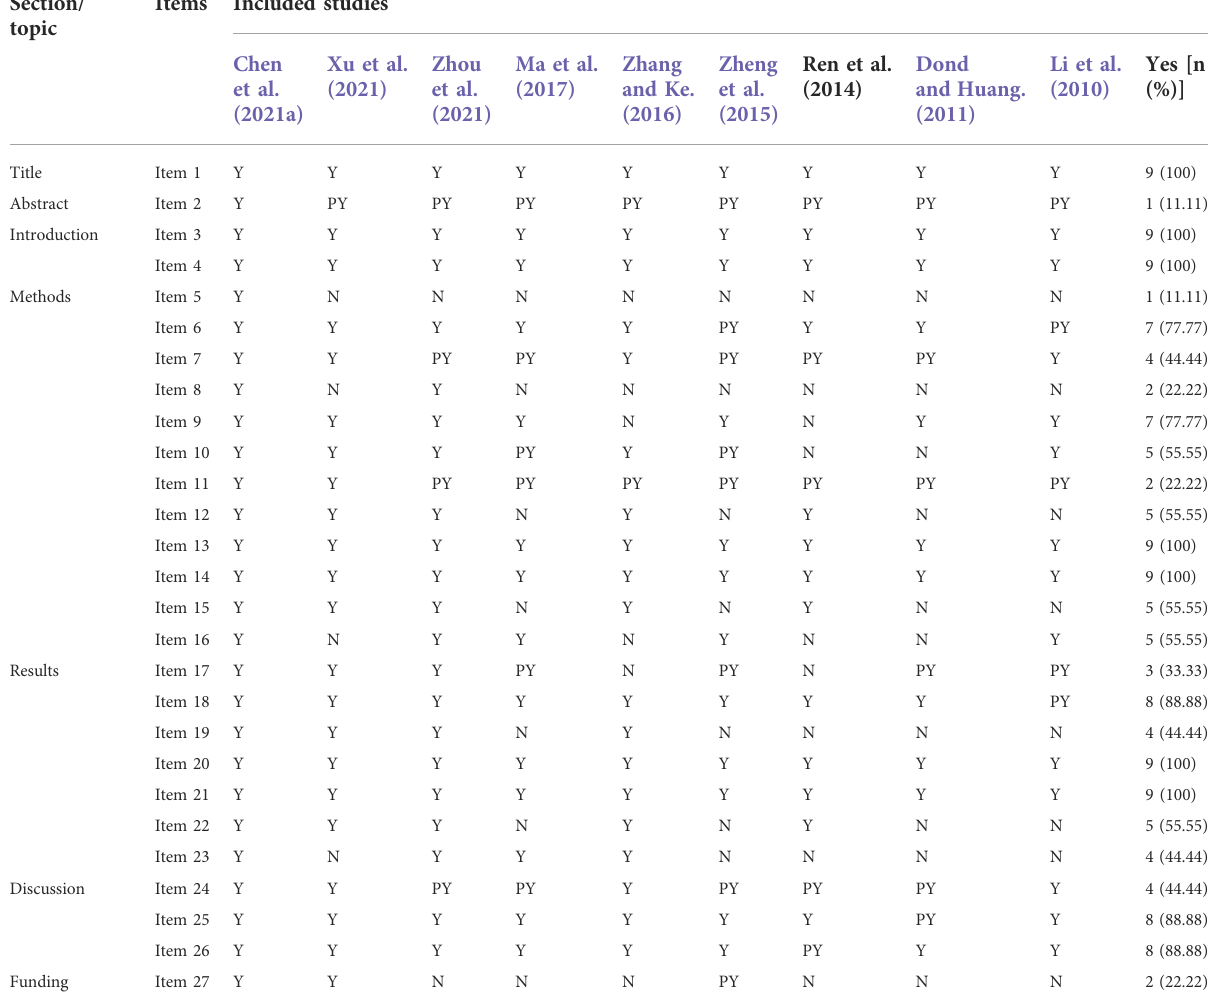
TABLE 3 Reporting quality assessment of SRs by PRISMA